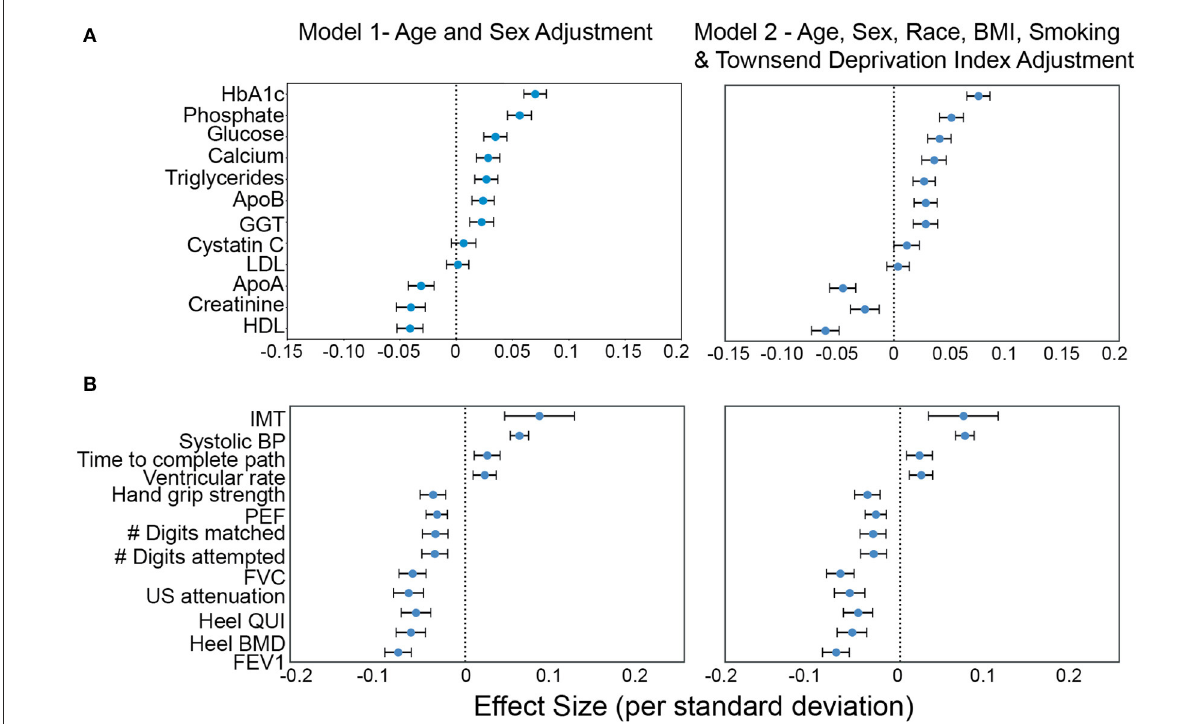
FIGURE7 Association of AAC with (A) molecular biomarkers, and (B) physiological parameters. Briefly, AAC is modeled as a linear function of each covariate adjusted for age + sex (model1) and age + sex + confounders (model2). The blue dot represents the mean effect size per standard deviation of different covariates while error bars represent the 95% confidence interval. With the exception of LDL and cystatin C, only covariates that passed multiple hypothesis testing in model 1 are shown (Bonferroni corrected p < 1.2e-4; see Methods Section Results). We include LDL and cystatin C as they are discussed in the text. Age during imaging visits was used to adjust for calcification levels. All other covariates and measurements were taken during the baseline